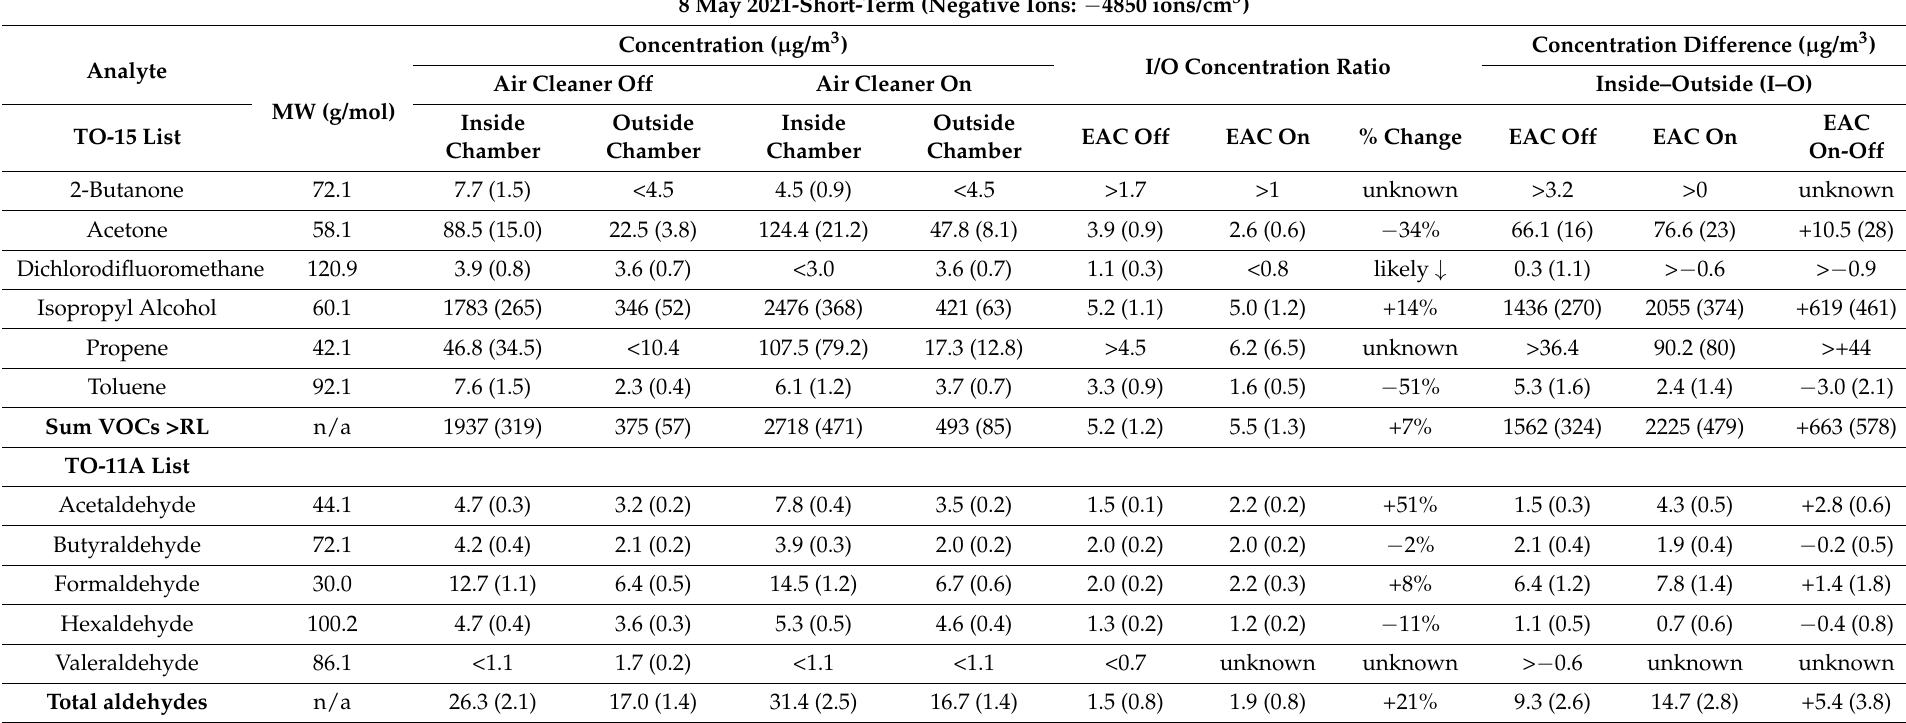
Table A2. Resulting concentrations and calculated inside/outside (I/O) chamber concentration ratios for TO-15/TO-11A analytes above reporting limits (RL) in at least one air sample from the 8 May 2021 short-term natural condition test. Symbols “likely ↑ ” and “likely ↓ ” denote likely, albeit not directly quantifiable, increases and decrease,